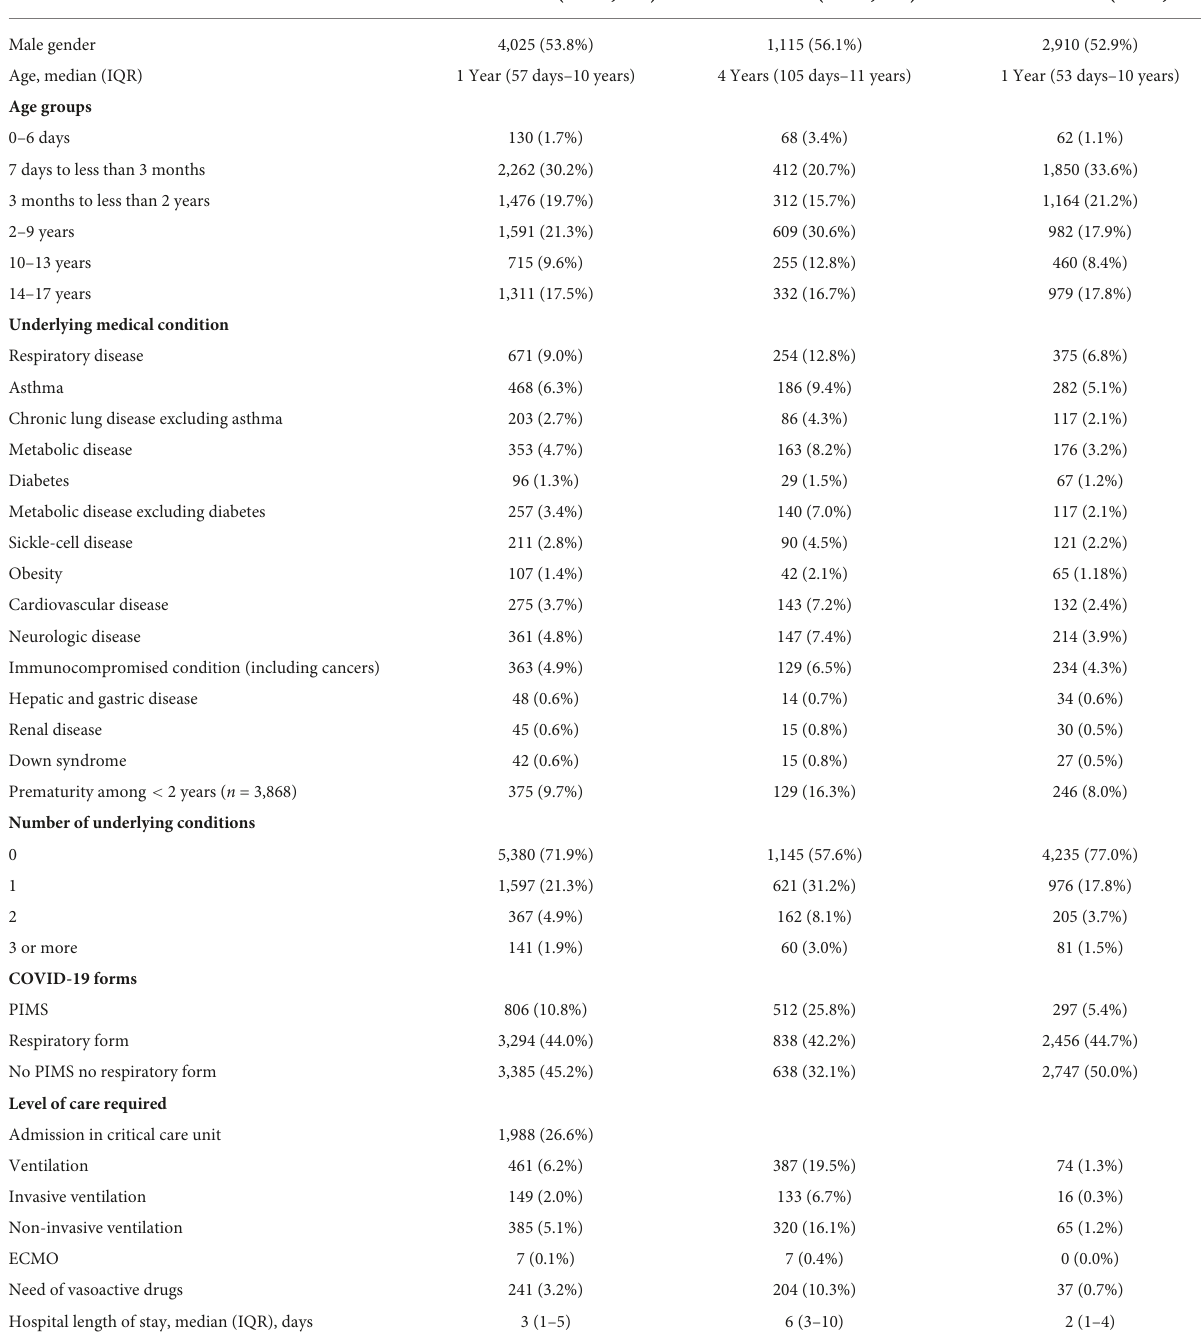
TABLE 1 Characteristics of the children hospitalized with